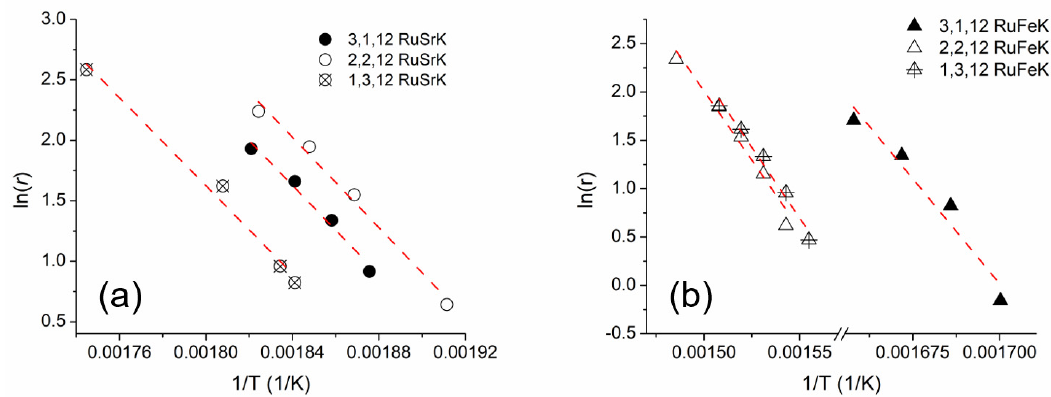
Figure 6. Arrhenius plot of ( a ) RuSrK and ( b ) RuFeK based catalysts. Reaction Conditions: 100% NH 3 , 5400 mL/hr/g cat and 1 bar. Apparent activation energies were conducted under differential conditions.